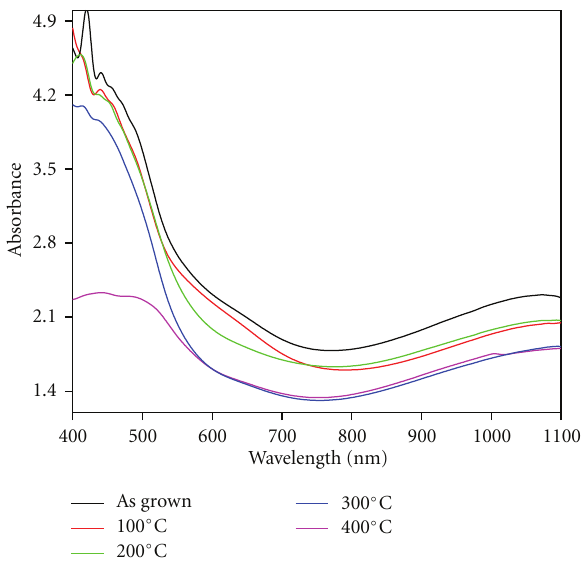
Figure 5: Plot of optical absorbance verses wavelength obtained for as grown and annealed Ag-doped nanostructured CdS thin films.